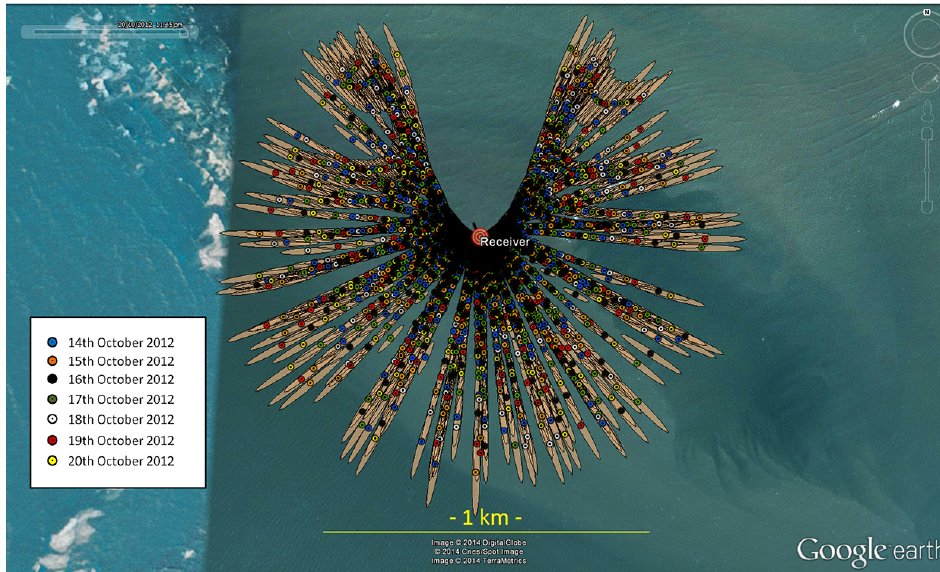
Figure 7. Positions of the specular reflection points and first Fresnel zones for one week of simulation on the Cordouan lighthouse with a 15min sampling rate (i.e., satellite positions actualized every 15min). Only GPS satellites with elevation angles greater than 5 ◦ have been considered. Note the gap in the northerly direction.